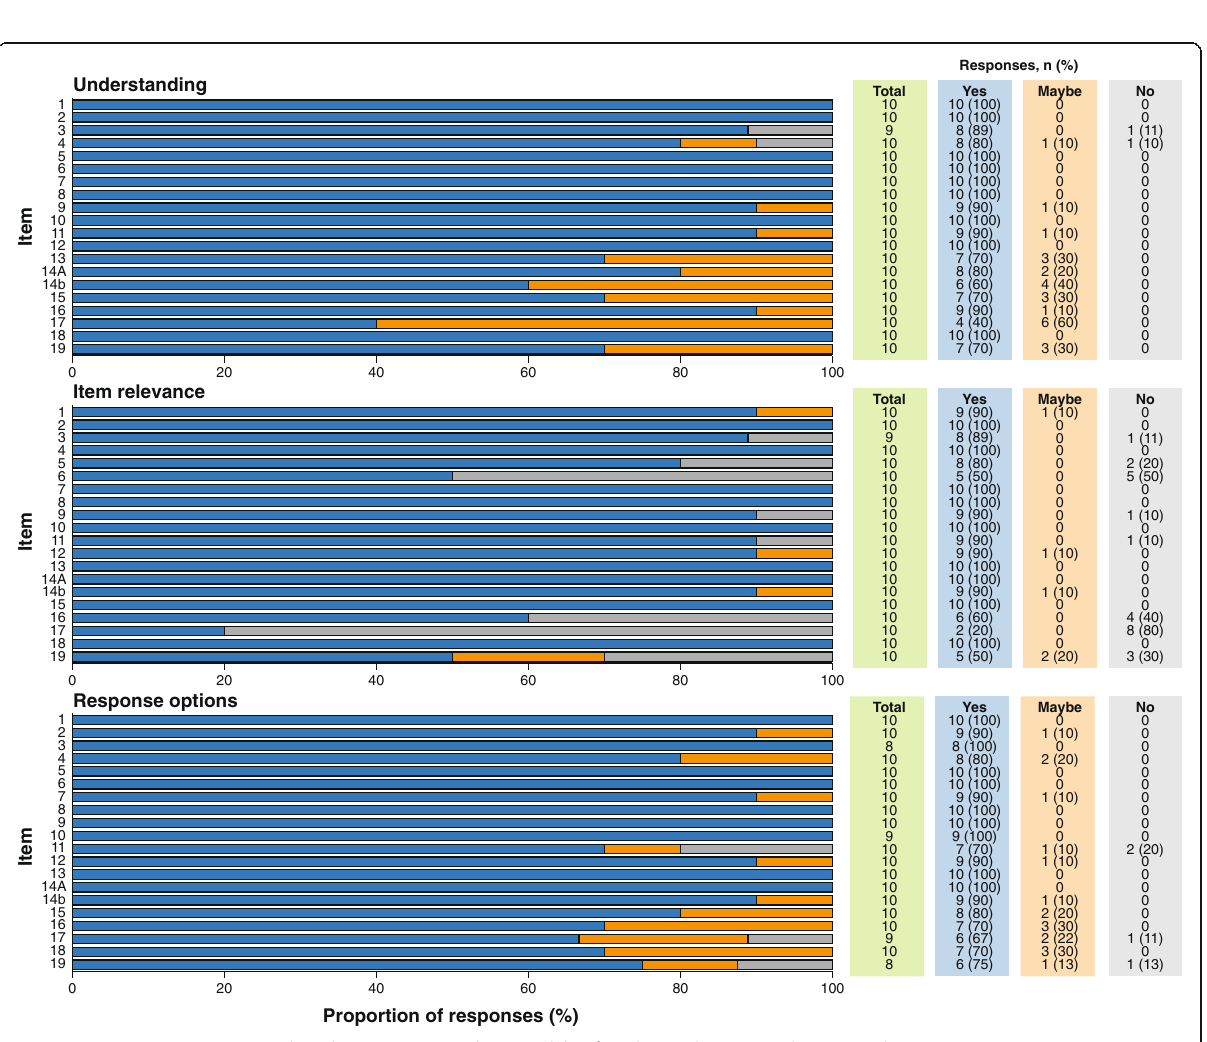
Item 5 – anxiety about the IV infusion Two changes to item 5 were suggested: changing the item to the past tense ( n = 1) and lengthening the recall period ( n = 1).